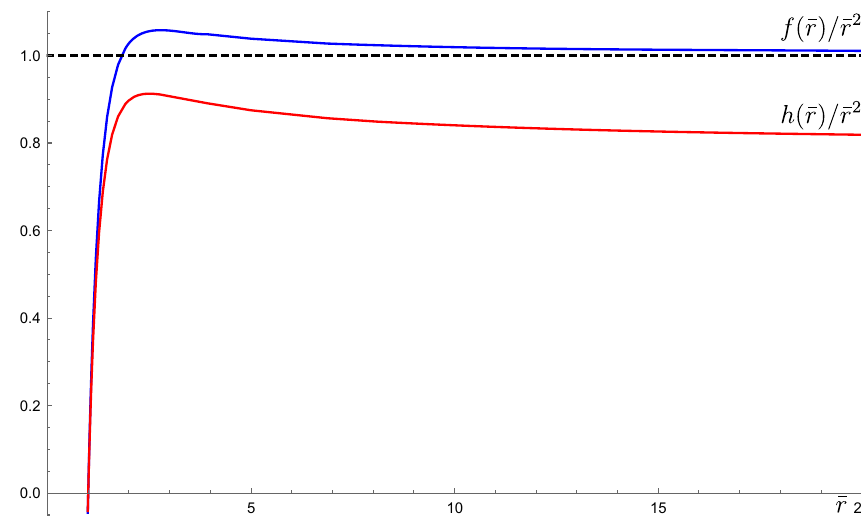
Fig. 2 Functions f ( ¯ r )/ ¯ r 2 and h ( ¯ r )/ ¯ r 2 for spherical Schwarzschild– Bach–AdS black holes obtained from the first 200 terms of series (41) and (42) for parameters r h = − 1, k = 1 / 3, b = 1 / 5, (cid:2) = − 3, (cid:9) = 1 (recall the gauge (59) is used here where, in general, h (cid:3)= f asymp- totically; however, this could be remedied by a gauge transformation t → σ t ). Further calculations suggest that, also within a certain range of parameters of the solution, fine-tuning of the Bach parameter b is